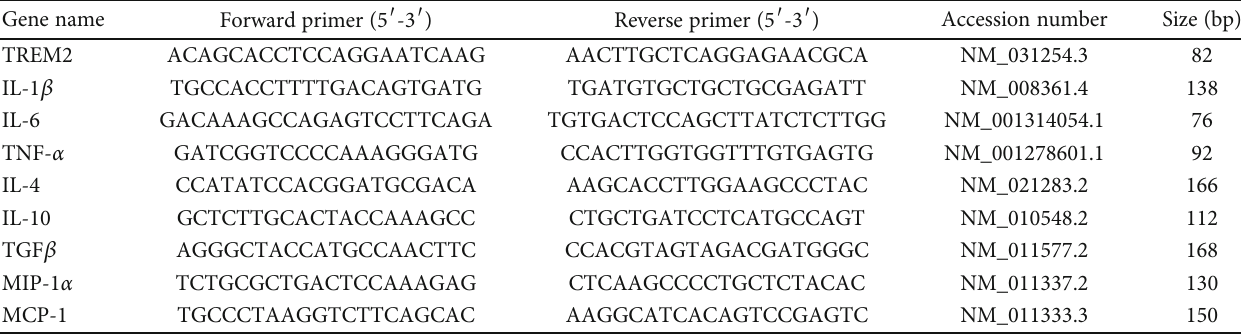
Table 1: Sequences of primers used in real-time